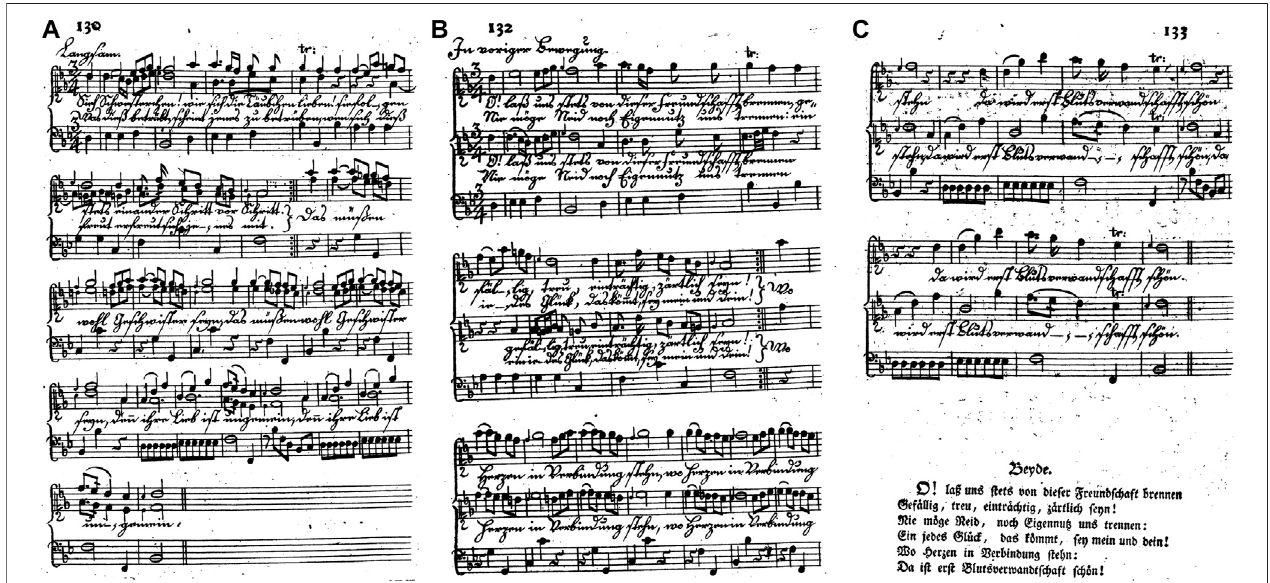
FIGURE 7 | Hiller, “ Brüderliche Eintracht ” (text: Weisse), from Lieder für Kinder (1769, 130 – 133).